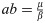
Polynomial governing the survival function.F(S) = βS2 − (β + μ + δ)S + μ is the RHS of (4) with parameter values β = 0.15 h−1, μ = 0.01 h−1 and δ = 0.01 h−1. The constants a and b satisfy ab=μβ and a+b=β+δ+μβ. The value of a is equal to the probability that the infected macrophage eliminates the infection, rather than ruptures.